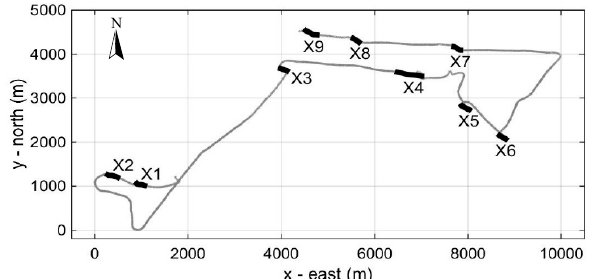
Figure 13. Vessel track on 7 June 2015 aiming at the localization of sperm whale X. The area corresponds to rectangle “X” in Figure 3. The drifting vessel positions during stations X1–X9 are marked by heavy lines.